Question: Briefly state, in one sentence, what is plotted here.
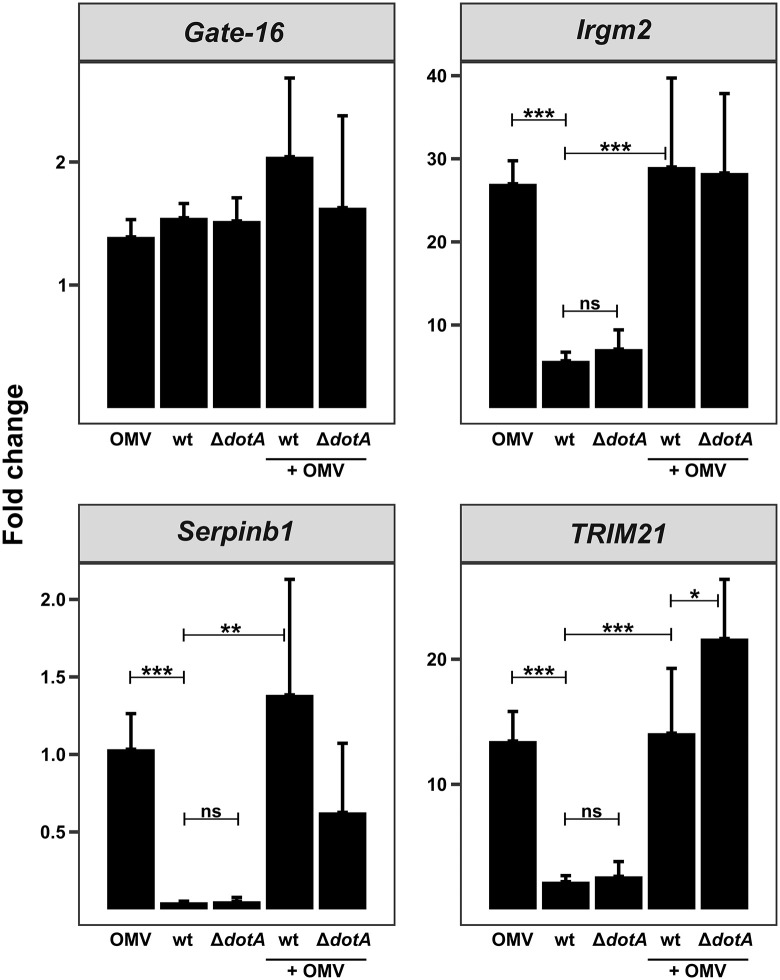
Answer: TRIM21 might be implicated in the lack of non-canonical inflammasome activation by C. burnetii , unlike GATE-16, Irgm1-3, or SerpinB1. BMDM were stimulated with OMVs for 8h, infected with C. burnetii wt or Δ dotA for 32h, or for 24h with subsequent OMV stimulation for 8h. The fold change in mRNA transcript level of the indicated targets was calculated relative to uninfected BMDM. Mean ± SD, n = 4, One-Way-ANOVA with Bonferroni post-test. **p < 0.01, ***p < 0.001.